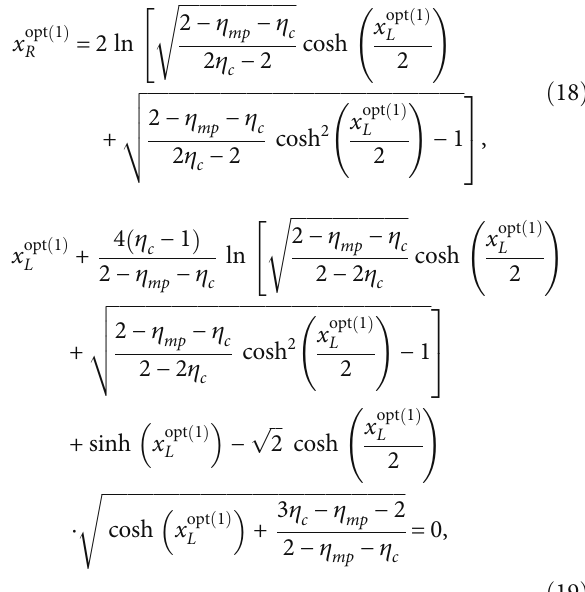
Figure 2: (Color online) Scaled electron energy barriers x maximum power and at the two optimization criteria condition, and the dotted line represents the corresponding (scaled) energy x R at maximum power and at the two cases of optimization criteria condition as a function of the Carnot e ffi ciency η c = 1 − T R / T L